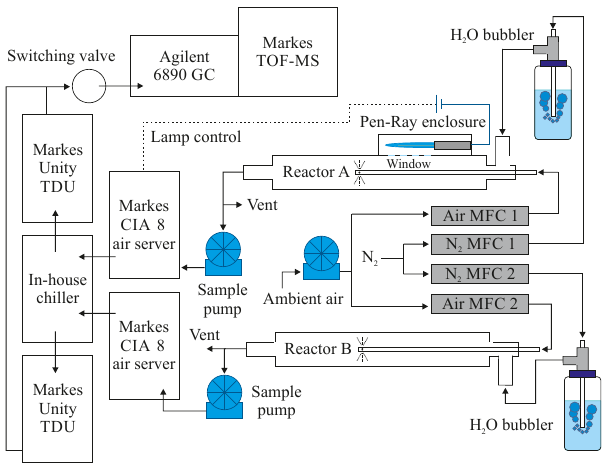
Figure 9. Schematic of the OH reactor configuration used for sam- pling ambient air VOC. CIA 8 is the air server and canister interface accessory; GC is the gas chromatograph; MFC is the mass flow con- troller; TOF-MS is the time-of-flight mass spectrometer; TDU is the thermal desorption unit.